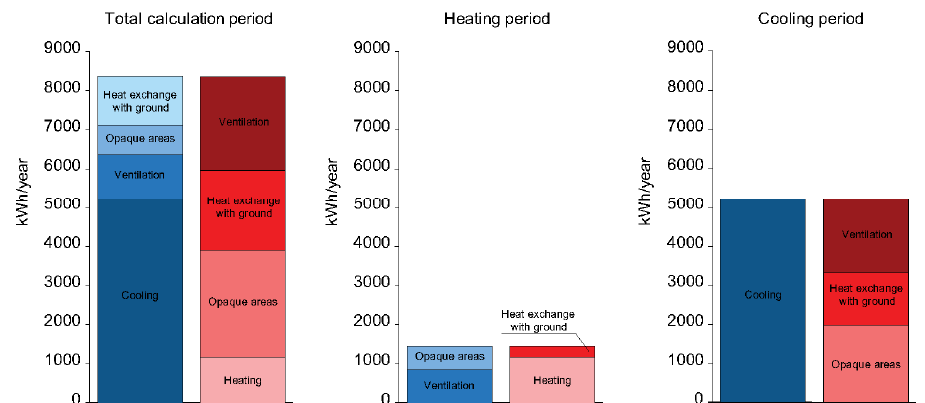
Figure 7. Energy balance for the tested cold store in annual terms, the period when reheating was required and in the cooling period.